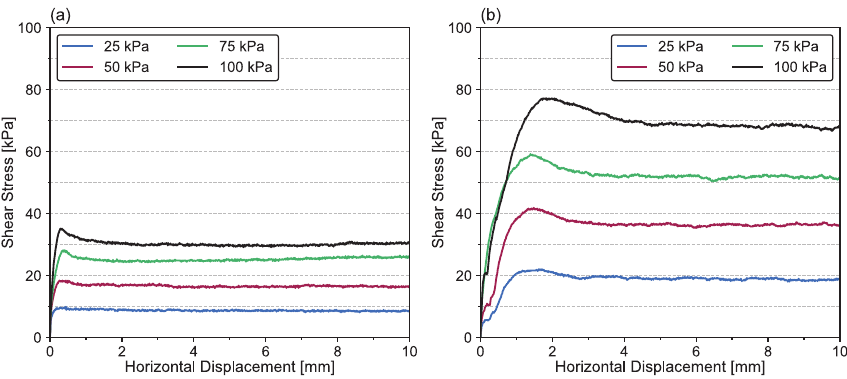
Figure 8. Shear stress as a function of horizontal displacement from interface direct shear test on JEZ-1-steel plate: ( a ) smooth and ( b ) rough surfaces.